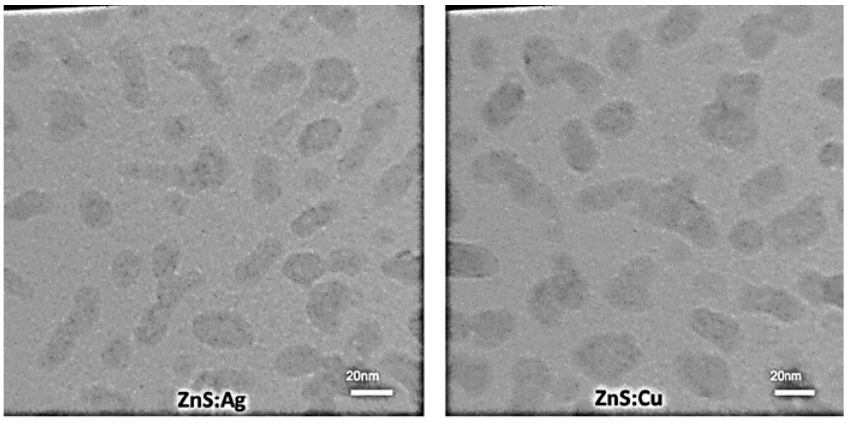
Fig. 4. The TEM image of produced ZnS:Ag and ZnS:Cu by hydrothermal